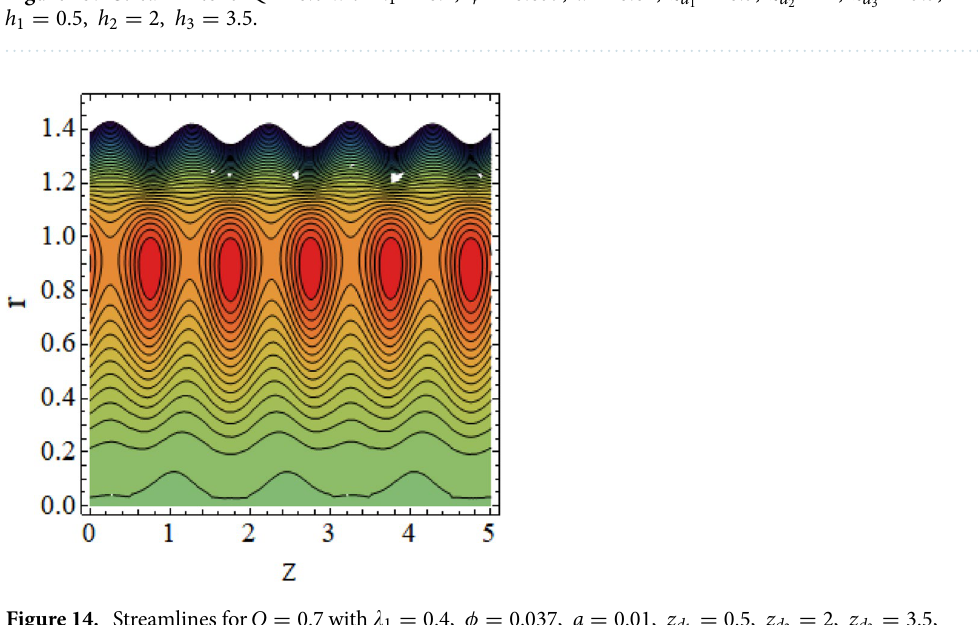
Figure 14. Streamlines for Q = 0.7 with (cid:31) 1 = 0.4, φ = 0.037, a = 0.01, z d 1 = 0.5, z d 2 = 2, z d 3 = 3.5, h 1 = 0.5, h 2 = 2, h 3 =